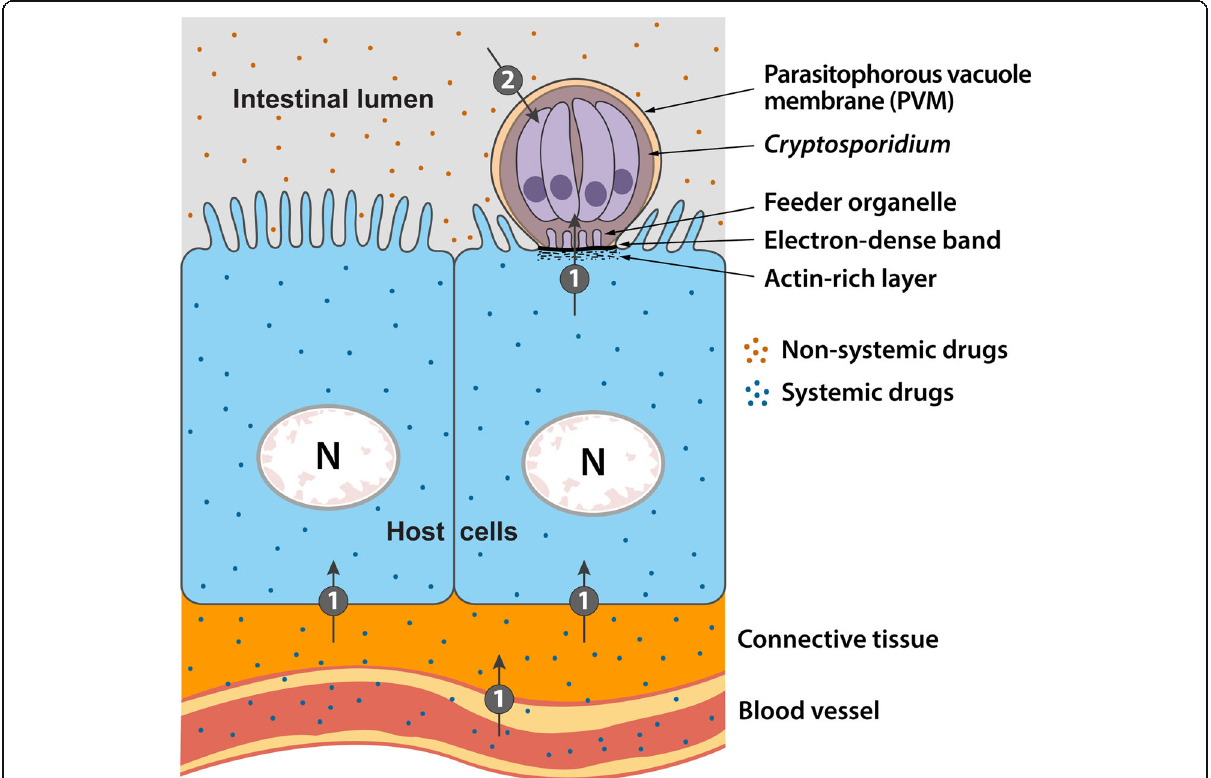
Fig. 2 Illustration of drug delivery routes for systemic and non-systemic drugs to an intracellular Cryptosporidium meront that is separated from host epithelial cell cytosol by an electron-dense (ED) band, but embraced by a host cell-derived parasitophorous vacuole membrane (PVM) facing the intestinal lumen. Systemic drugs need to cross through the selective ED band and feeder organelle (route 1), while luminal non-systemic drugs may directly act on parasite through PVM (route 2). A regular 2D culture system is unable to evaluate systemic drug route since the basal surface of host cells is attached to a nonporous plastic surface. Credit to Lin Xia and Wenjuan Wang for